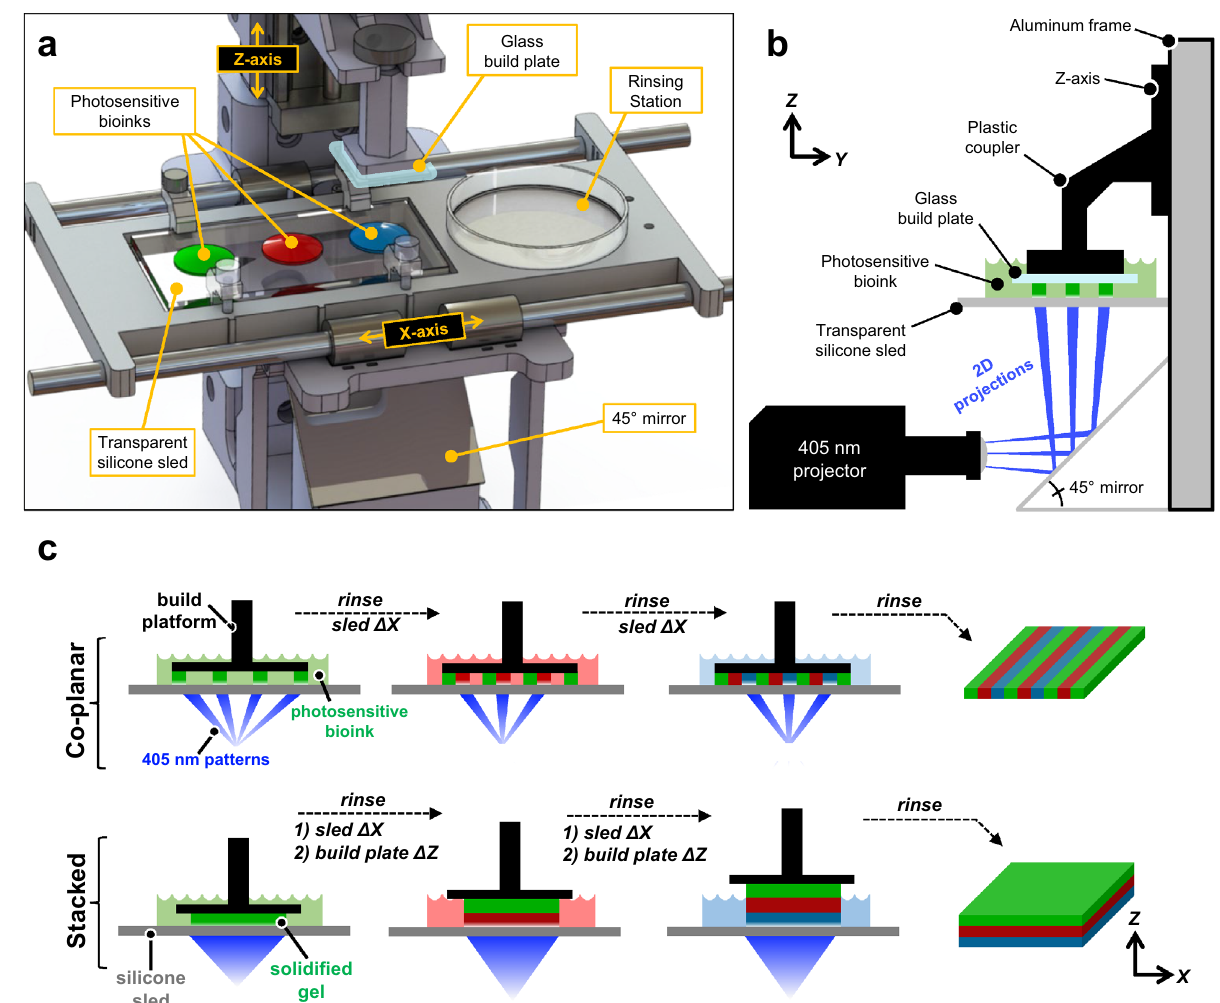
Figure 1. Design and workflow for a multi-material stereolithography bioprinter. ( a ) Perspective view rendering of bioprinter components and final design; note the presence of a motorized silicone sled, which translates laterally in the X-axis to automate bioink selection and rinsing. ( b ) Side view schematic showing the glass build plate lowered into a bioink droplet, creating a thin first layer (50 μm) for photocrosslinking. ( c ) Print workflow for fabricating monolithic gels with spatially controlled heterogeneity. The motorized sled allows nascent structures to interface with separate bioinks of variable chemical or cellular composition, providing heterogeneity within individuals layer (co-planar; XY) and across sequential layers (stacked;